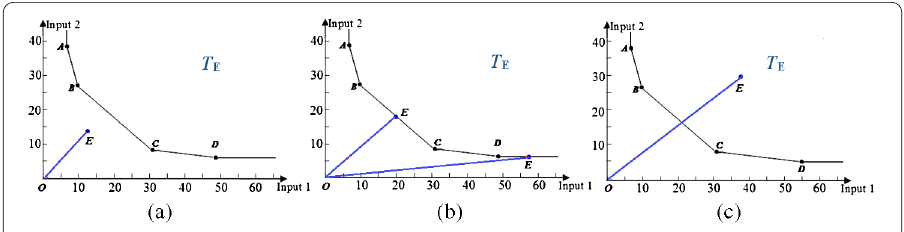
Figure 1 Efficiency analysis of the evaluated